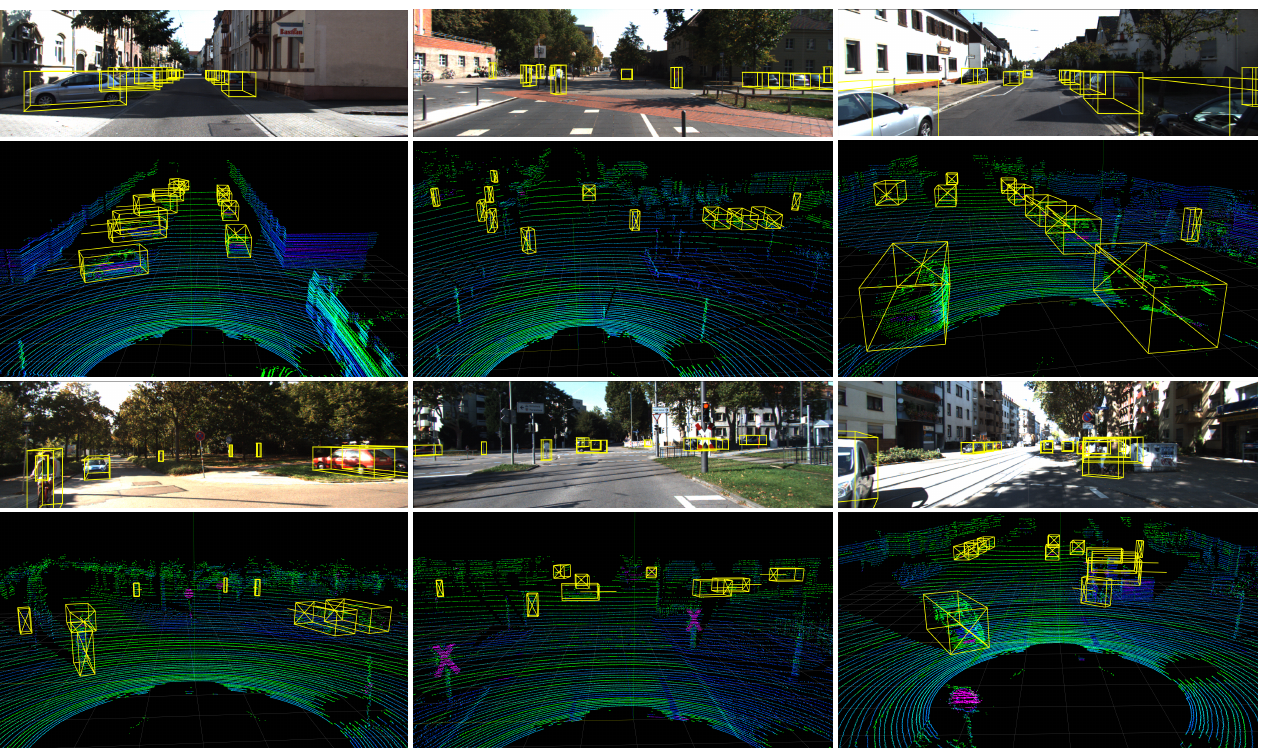
Figure 4. Qualitative results on the KITTI test set. The predicted bounding boxes are shown in yellow. The predictions are projected onto the images for better